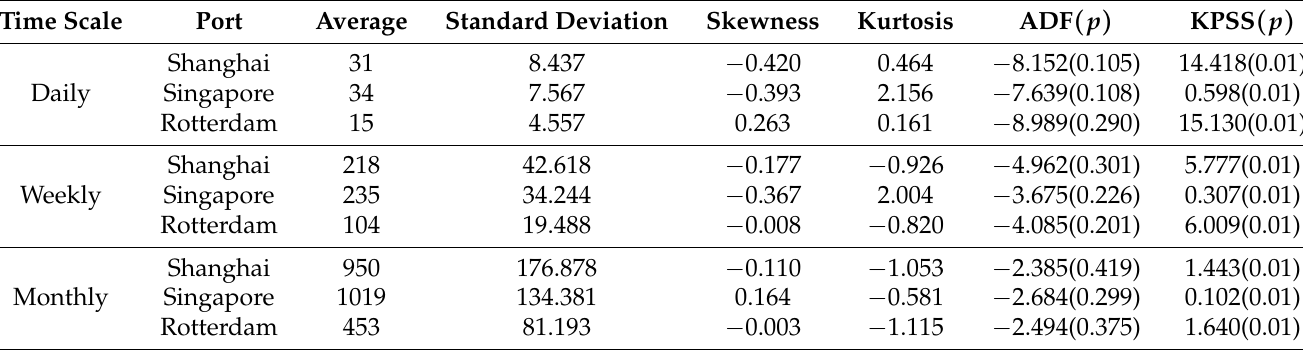
Table 2. Descriptive statistics of the original ship flow